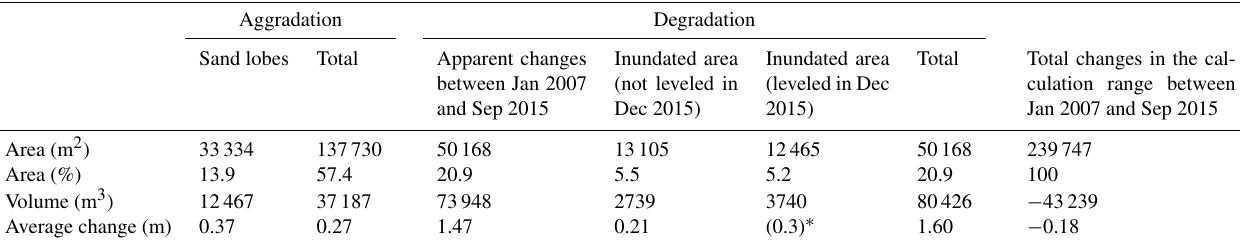
Table 3. Results of the volumetric calculations (changes between January 2007 and September 2015). Aggradation